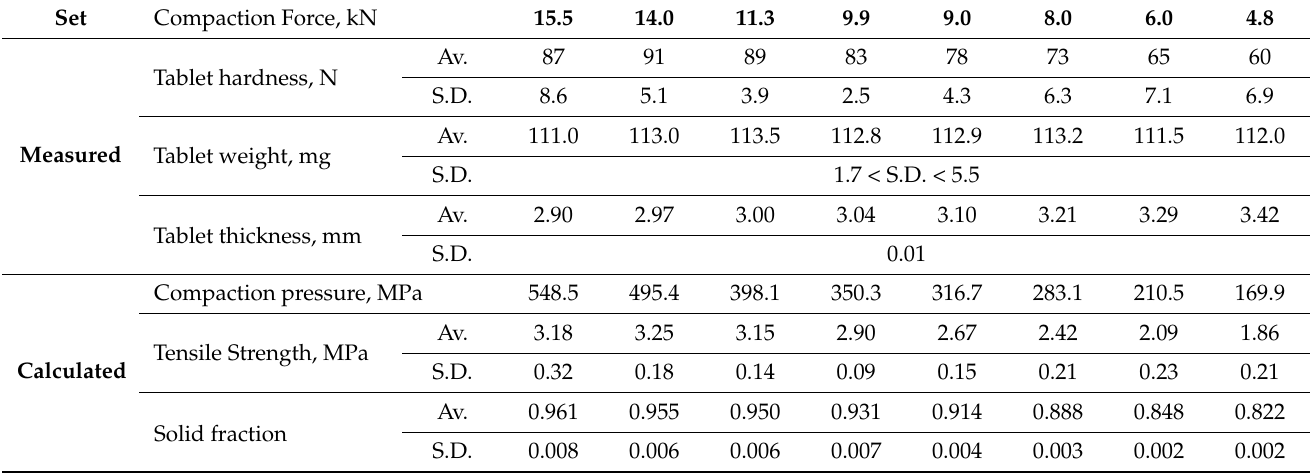
Table 3. Tableting characteristics: measured and